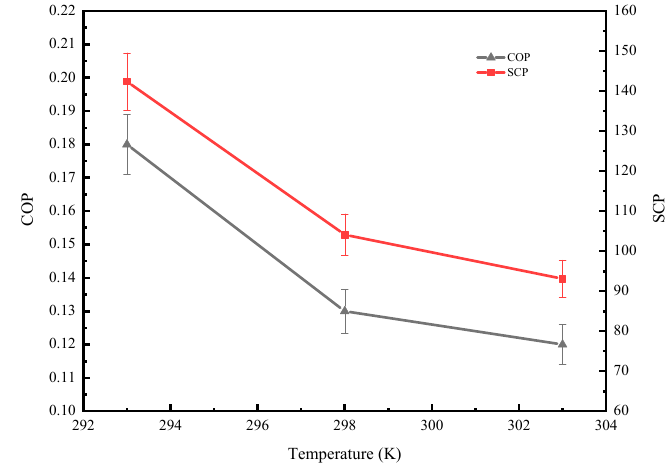
Figure 15. COP and SCP of the system at different adsorption temperatures.